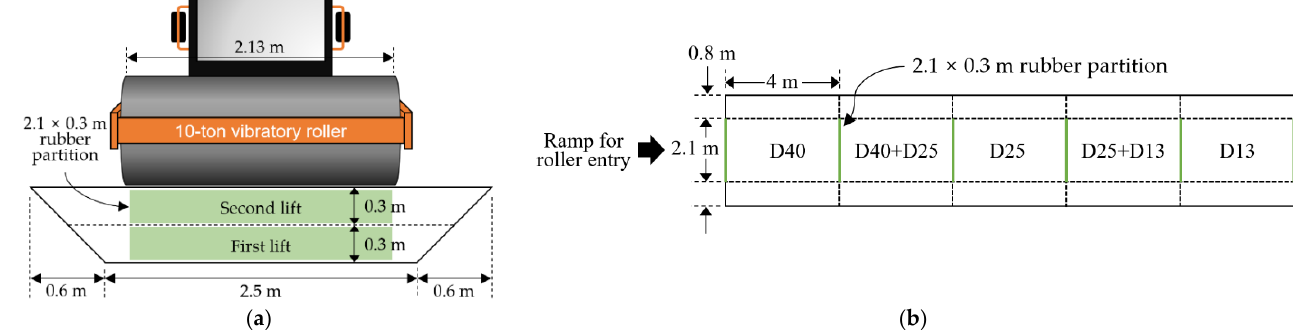
Figure 5. Testbed layout [38]. ( a ) Cross-sectional view; ( b ) plan view.